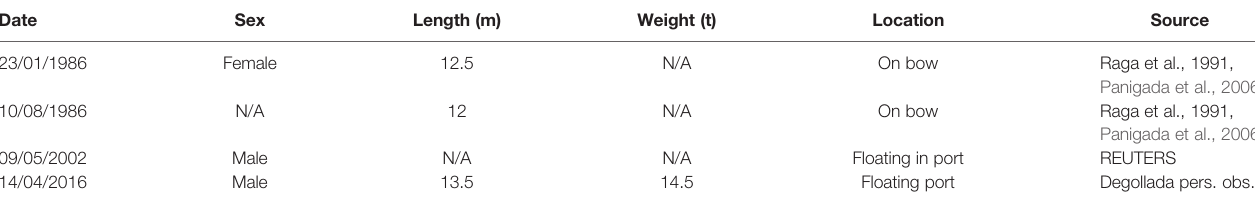
TABLE 1 | Con fi rmed fi n whale ship strikes at Barcelona Port since 1986.